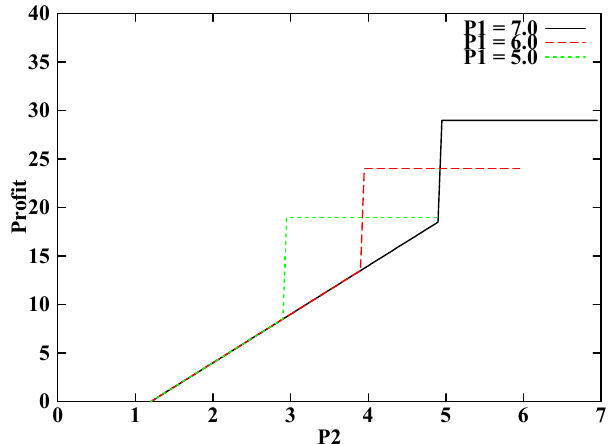
Figure 10. System behavior in the pruned zone.